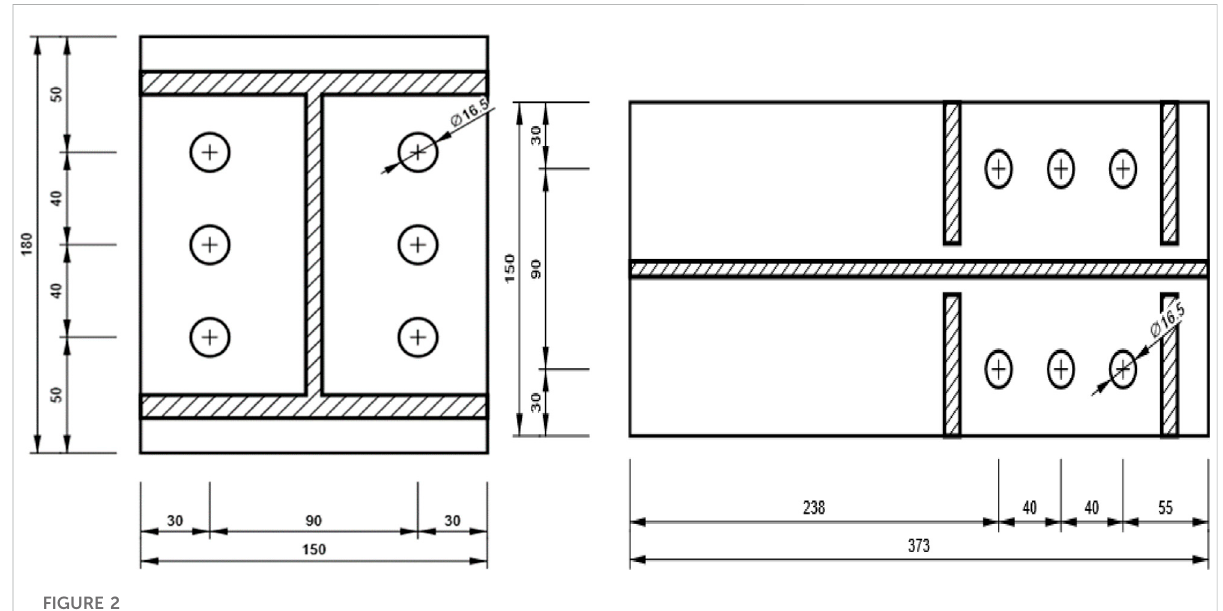
FIGURE 2 Semi-rigid beam-column connection properties (unit: